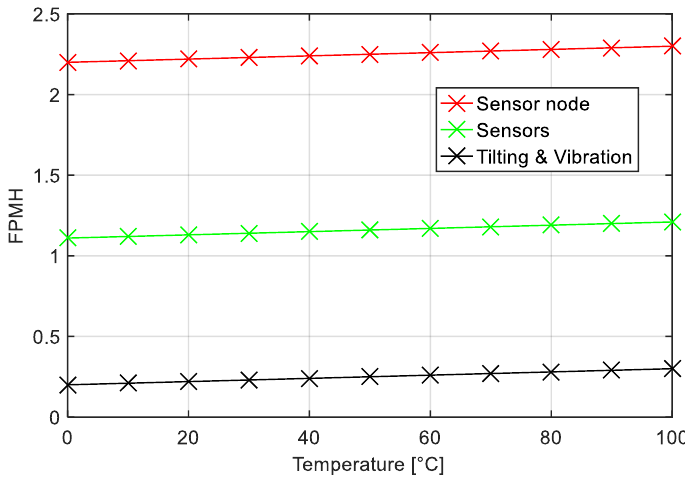
Figure 6. Expected number of failures for each individual subsystem composing the sensor node structure as a function of the temperature and considering the ‘continuous’ mode. Red line: failure modes of whole sensor node; light green line: failure rates of the sensors module; yellow line: failure mode of the tilting and vibration module, 100% GB.